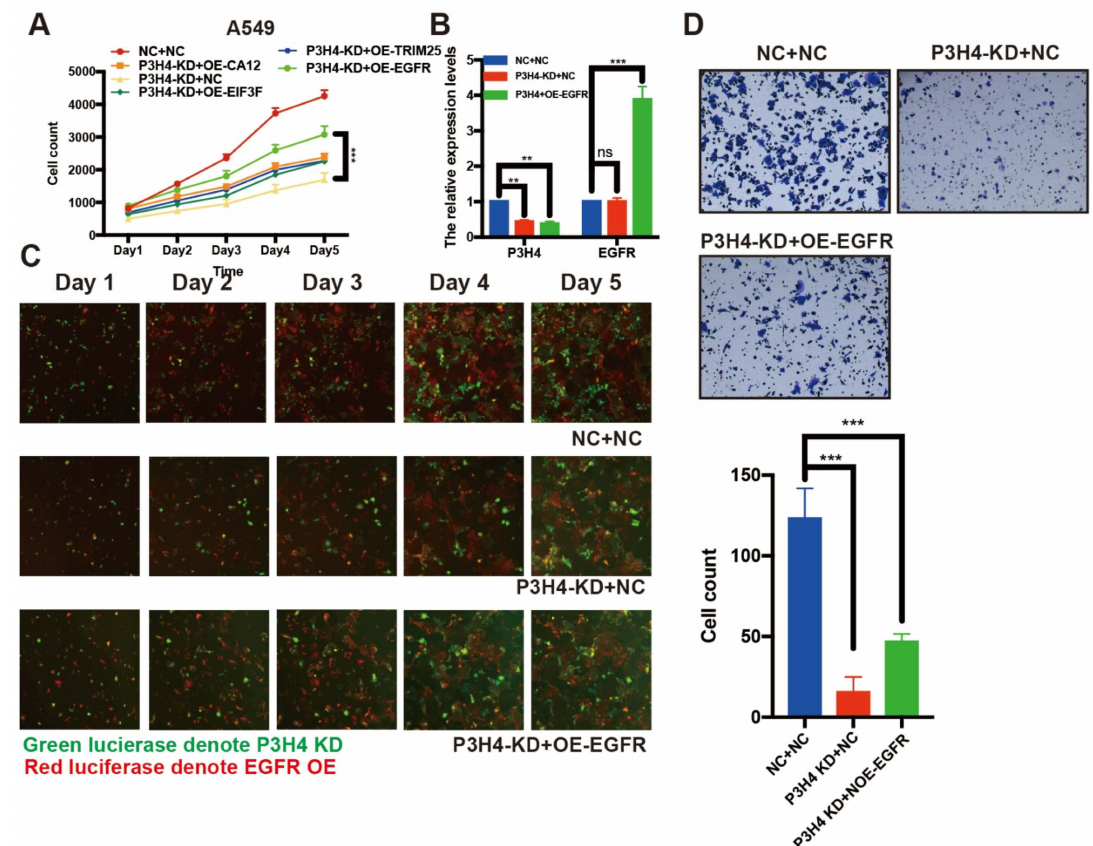
Figure 5. EGFR rescue the effects of P3H4 knockdown in LUAD cells. ( A ) The expression of EFGR blocked the suppression of proliferation induced by P3H4 knockdown (*** p < 0.001 vs. P3H4-KD + OE-EGFR, multiple-comparison two-way ANOVA, n = 3). ( B ) QRT-PCR revealed the efficiency of P3H4 knockdown and EGFR overexpression (*** p < 0.001, ** p < 0.01 vs. NC + NC, multiple-comparison two-way ANOVA, n = 3). ( C ) The proliferation of A549 cells upon P3H4 knockdown and EGFR overexpression lentivirus infection. ( D ) The representative images indicate that EGFR blocked the migration suppression following P3H4 knockdown (*** p < 0.001 vs. NC + NC, multiple-comparison two-way ANOVA, n =